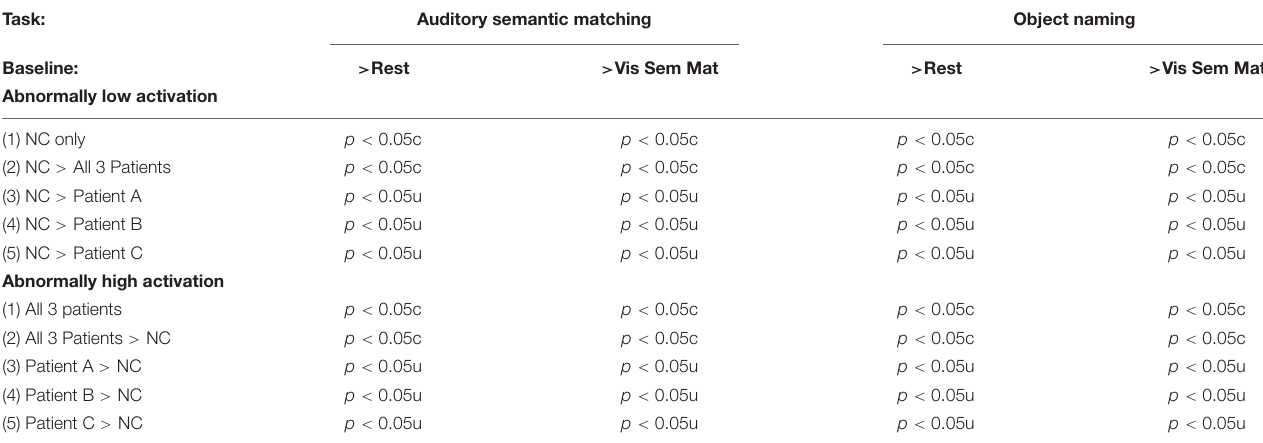
TABLE 2 | Statistical criteria and thresholds used for identifying abnormal activation.